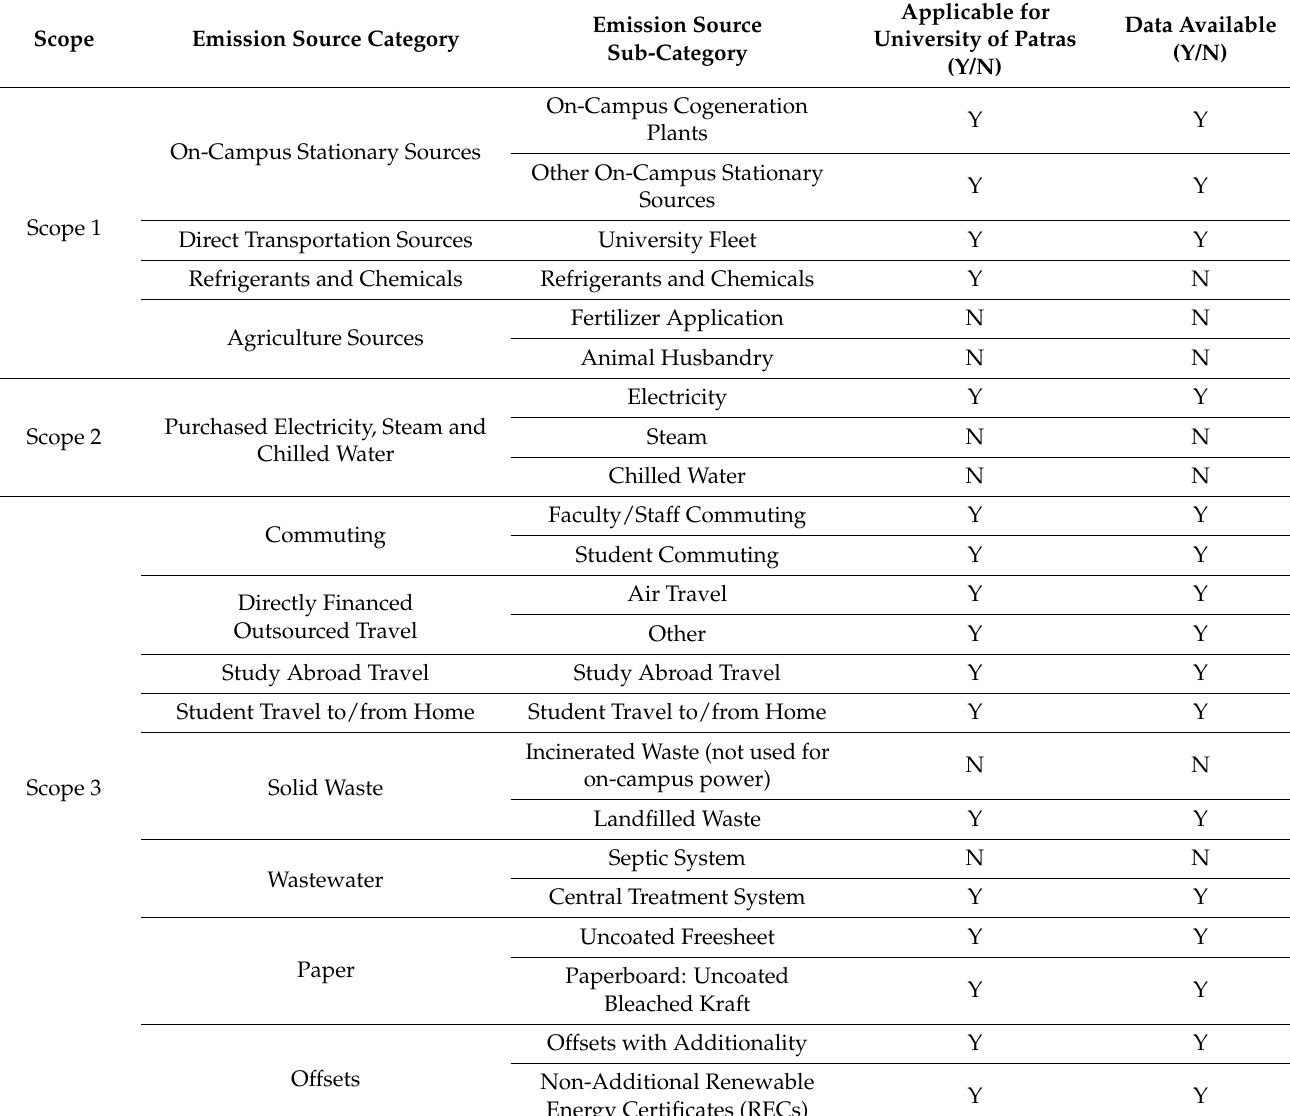
Table 1. Data used for the University of Patras carbon footprint